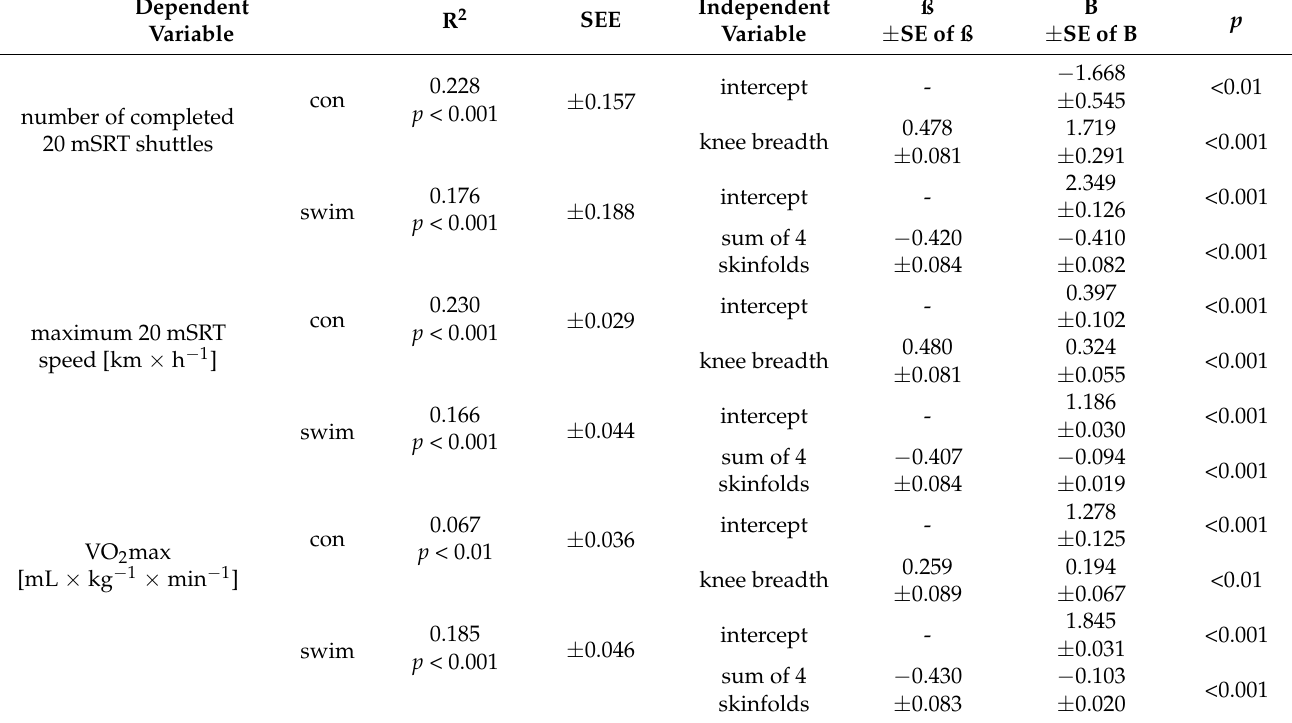
Table 5. The results of a stepwise multiple regression analysis with backward elimination for dependent variables: number of completed 20 mSRT shuttles, maximum 20 mSRT speed, and maximum oxygen uptake (VO 2 max) predicted on the basis of 20